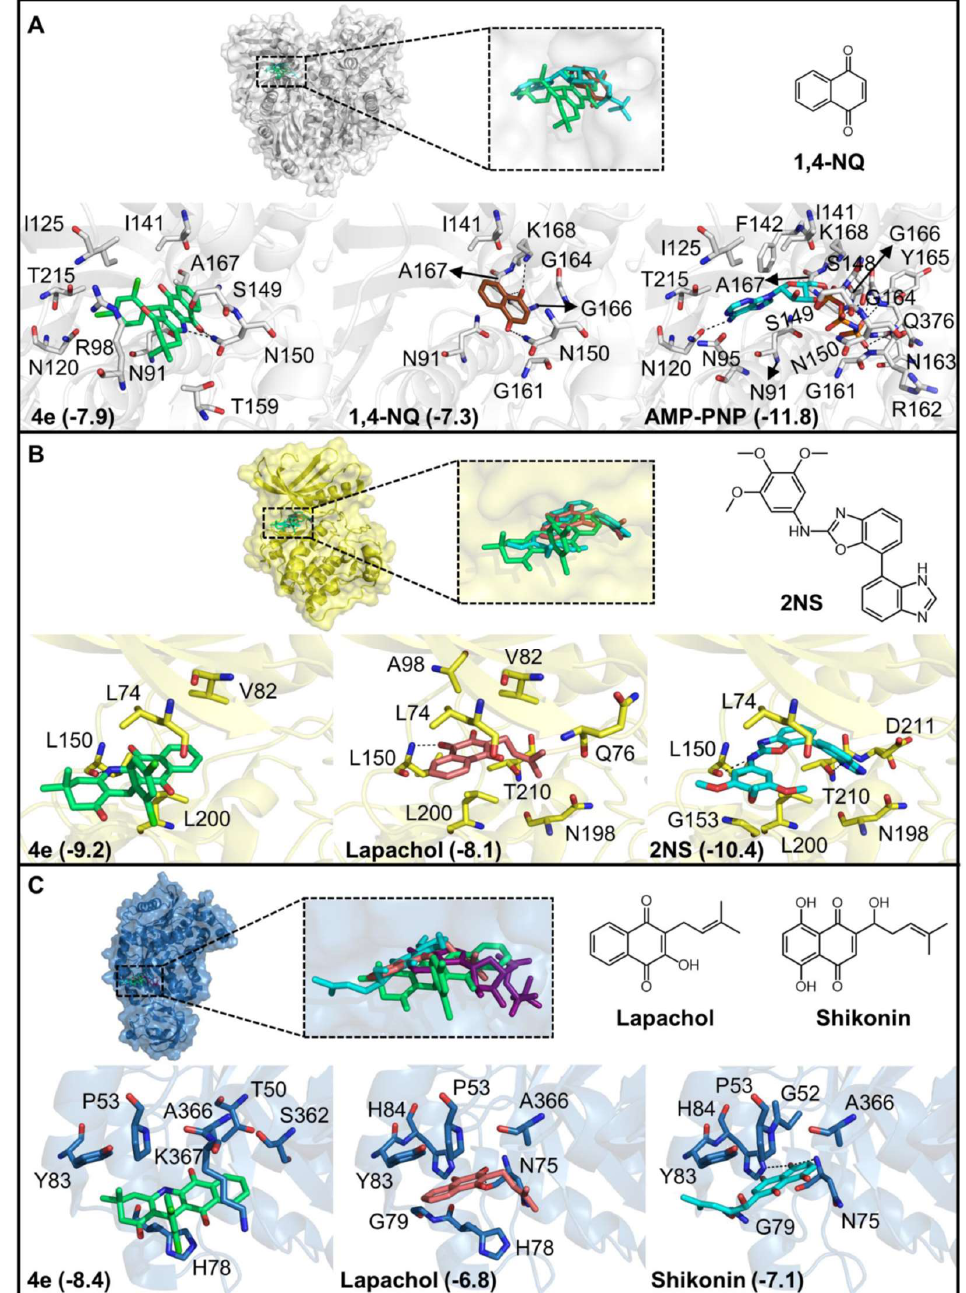
Figure 5. Docking of compound 4e with its putative anticancer targets and comparison with the known inhibitors. Superimposition and interaction pattern of ( A ) 4e (green), 1,4-naphthoquinone (1,4-NQ; brown), and AMP-PNP (cyan) with the ATPase domain of topoisomerase IIα; ( B ) 4e (green), lapachol (pink), and 2NS (cyan) with RSK2; ( C ) 4e (green), lapachol (pink), and shikonin (cyan) with PKM2. The ATP bound to the rabbit PKM2 is also shown in purple in the superimposition. Hydrogen bonds and salt bridges are shown as dashed lines. The predicted binding energies of the compounds with the respective enzymes are shown in parenthesis (in Kcal/mol). The binding energies of the co-crystallized inhibitors were calculated by redocking studies.